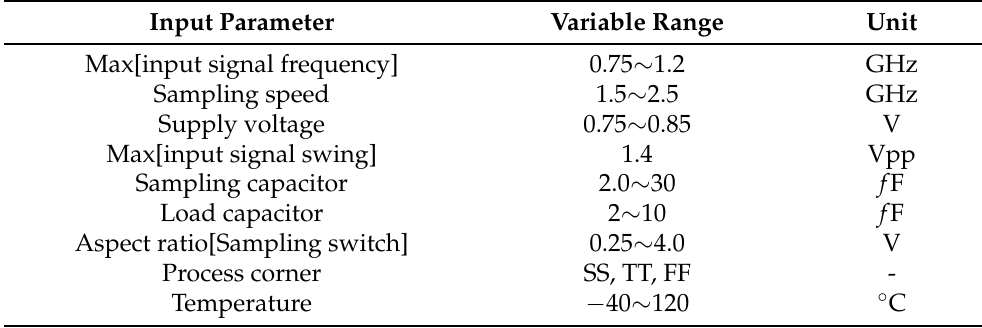
Table 1. Design input parameters of the T/H module.